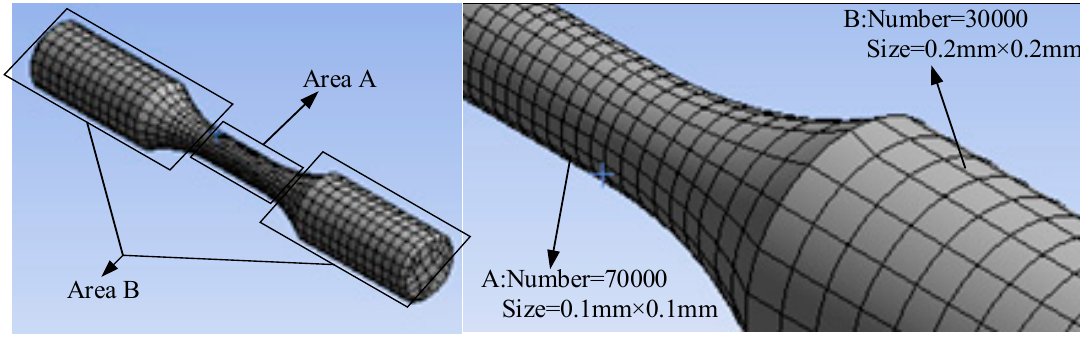
Figure 8. Element Figure 8. Element division.